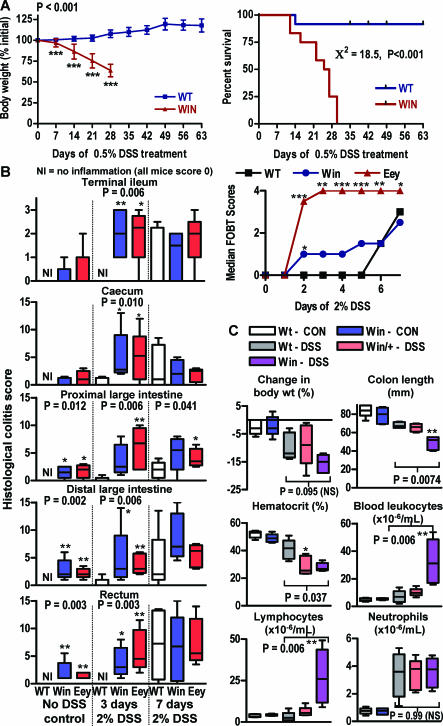
Susceptibility of Mice with Muc2 Mutations to Dextran Sodium Sulphate–Induced Colitis(A) Wild-type (WT) C57BL/6 and Winnie (Win) mice (n = 12) were given 0.5% DSS in drinking water for 63 d. Body weight (mean ± standard deviation, ANOVA p-value shown, Bonferroni's post-hoc test versus wild-type mice, *** p < 0.001) and overall survival (Kaplan-Meier survival estimates and Mantel log-rank test [χ2-value]) are shown.(B) Wild-type C57BL/6 (WT), and Winnie (Win), and Eeyore (Eey) mice not manifesting rectal bleeding or prolapse (n = 6) were given 2% DSS in drinking water or water alone for 7 d. Histological colitis scores were determined on days 3 and 7 and faecal occult blood determined daily. Statistics: box plots show median, quartiles, and range; p-values for Kruskal-Wallis nonparametric analysis are shown, Dunn's multiple comparison test versus WT, * p < 0.05, ** p < 0.01, *** p < 0.001.(C) Wild-type C57BL/6, Winnie, and Winnie heterozygous (Win/+) mice (n = 5) were given 3% DSS in drinking water or drinking water alone (CON) for 7 d, at which time body weight, colon length, and haematology were assessed. Statistics: box plots show median, quartiles, and range; p-values for Kruskal-Wallis nonparametric analysis comparing DSS-treated WT, Win/+, and Win mice are shown, Dunn's multiple comparison test versus WT, * p < 0.05, ** p < 0.01; NS, not significant. Additional data from these experiments are shown in Figures S2 and S3.